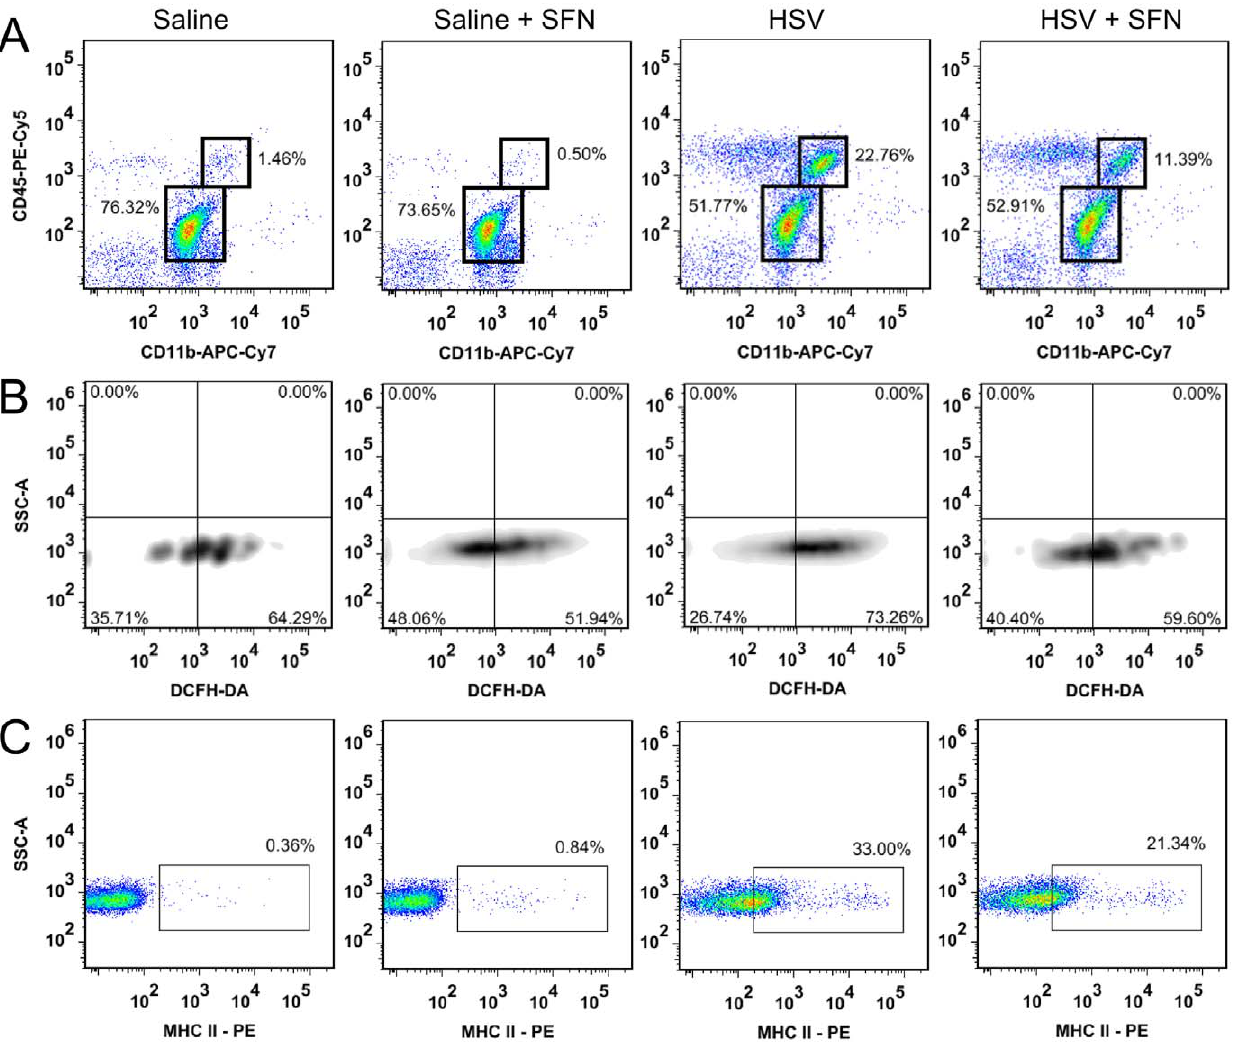
Figure 8. Systemic sulforaphane reduces macrophage infiltration, macrophage-specific ROS, and microglial activation in the brains of herpes encephalitic mice. Balb/c mice were infected with HSV-1 and given four 100 m l doses of SFN (50 mg/kg) or saline between 3–6 d p.i.. At 7 d p.i. whole brain leukocytes were isolated and stained for flow cytometry. ( A ) Flow cytometry plots of CD45 and CD11b staining in both uninfected and HSV-infected mice with or without SFN treatment. CD11b + , CD45 hi macrophages and neutrophils are highlighted in the upper box and microglial cells (CD11b + , CD45 int ) in the lower box. ( B ) CD11b + , CD45 hi macrophages/neutrophils were gated on for DCFH-DA analysis of ROS production. Cells were subdivided into high (bottom right quadrant) and low (bottom left quadrant) DCFH-DA expressing groups. ( C ) The percentage of activated microglial cells activation was assessed in both uninfected and HSV-infected mice with or without SFN treatment by detection of MHCII expression on CD11b + , CD45 int cells. (Figure 8C) as well as reduced the number of brain-infiltrating macrophages/neutrophils (Figure 8A). Microglial cells, which normally do not express MHCII but upregulate the activation marker by exposure to interferon- c [40], were shown to express significantly less MHCII in HSV-infected mice treated with SFN.